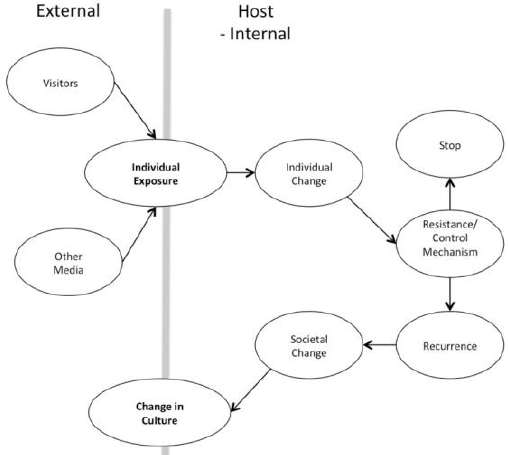
Figure 11. Process Diagram of Cultural Change (Author’s elaboration from Koentjaraningrat, 2016, Robinson and